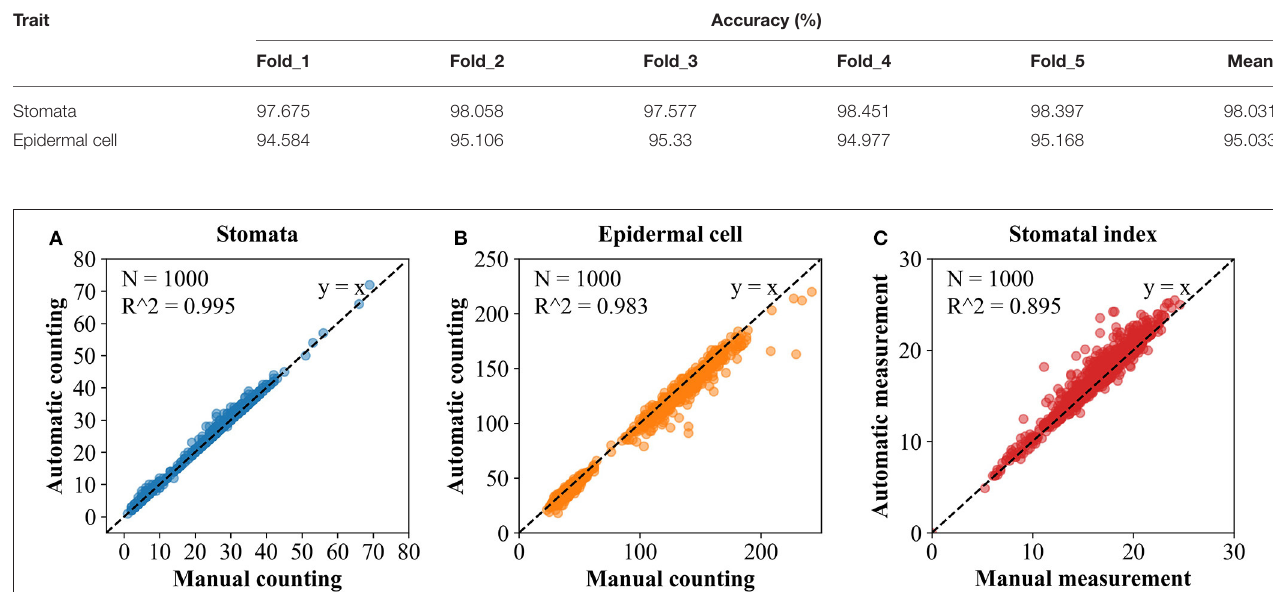
FIGURE 7 | Example images of epidermal cell segmentation by the U-Net-based model and morphological post-processing on a 20 the wheat leaf. (A) Ground truth. (B) Epidermal cell network predicted by U-Net. (C) Bilateral filtering and binarization; Red circles highlighted the breakpoints in the cell network. (D) Morphological opening operation; red circles highlighted connected breakpoints in the cell network after the morphological opening operation. (E) Connected domains with different colors (45 connected domains). (F) Epidermal cell counting after area filtering (39 epidermal cells). The six small connected domains that were filtered out were marked with red color.